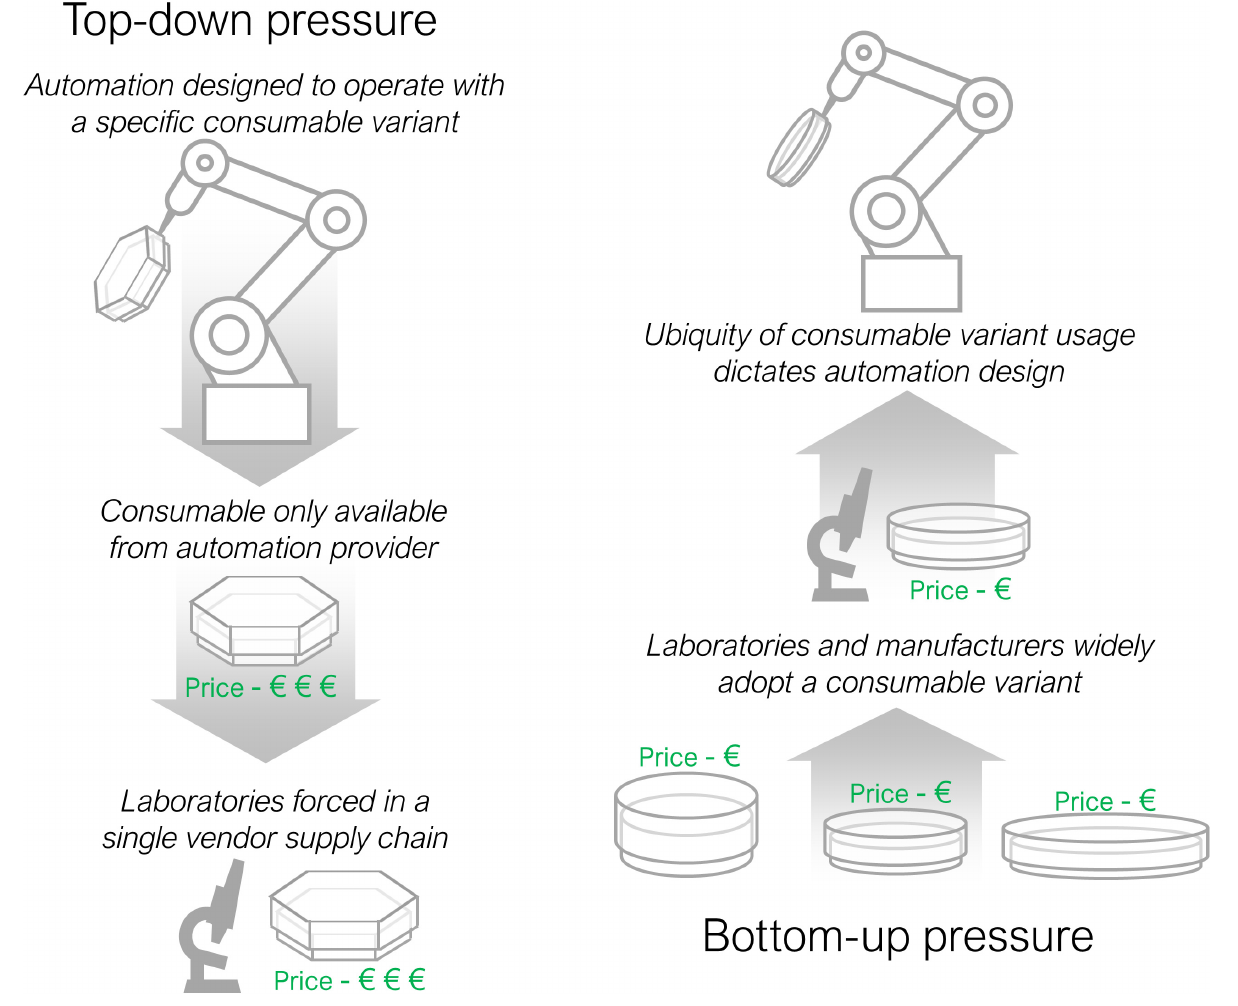
FIGURE 3 | Top-down and bottom-up consumable adoption pressures. Top-down pressure occurs when an automation developer imposes a consumable on laboratories through tooling specific design. Bottom-up pressure acts in the reverse direction with laboratories and automation suppliers coalescing behind one consumable variant that then determines the design of automation